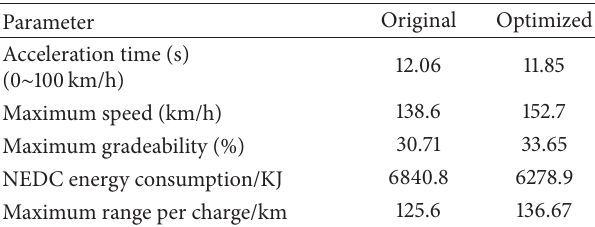
Table5:Thesimulationresultscomparedbeforeandafteroptimiza- tion.